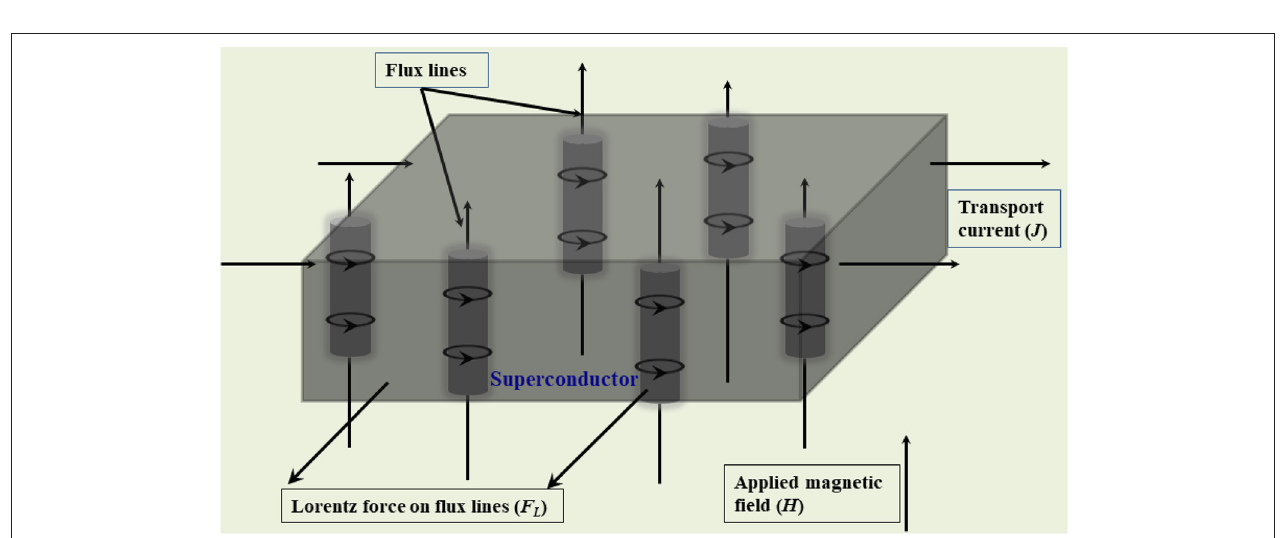
FIGURE 2 | Mixed state in a type II superconductor. Magnetic flux starts penetrating the sample in the form of small “tubes” (vortices), each with quantized flux h/(2e) Φ 0 =